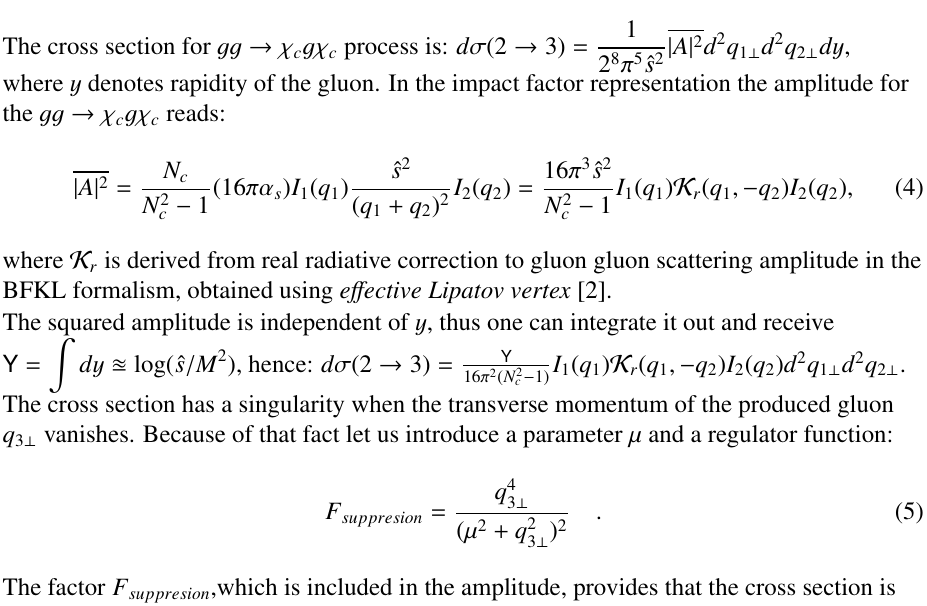
Figure 2. Di ff erential cross section as a function of rapidity. There are shown results for gluon distribution in the middle of the figure and also distribution of χ C (0) with higher order